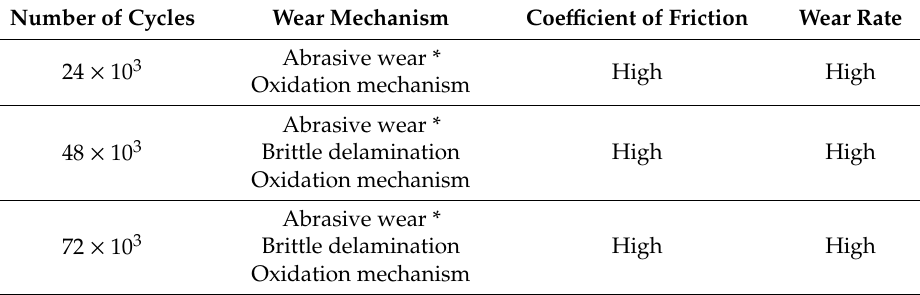
Figure 11. SEM-BSE images of the central region of the wear scars and their corresponding 3D surface morphologies under the normal load of 70 N after fretting cycles of 24 × 10 3 ( a , b ), 48 × 10 3 ( c , d ), and 72 × 10 3 ( e , f ), and the higher magnification SEM-BSE image corresponding to the rectangular area. Table 4. The wear mechanisms of nitrided specimens at di ff erent stages of testing under the load of 70